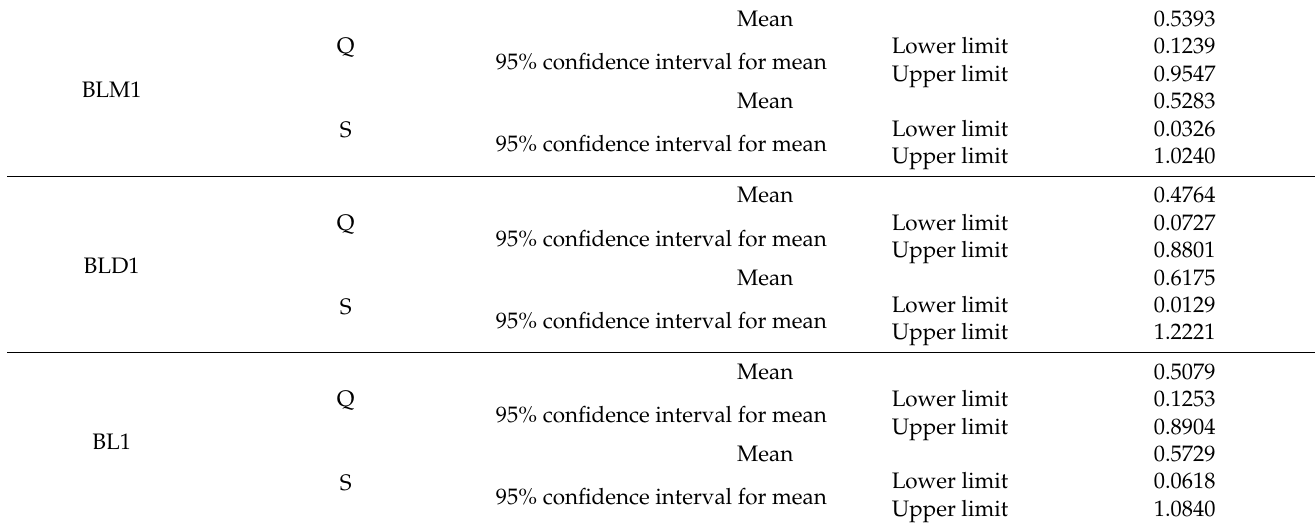
Table 1. Bone level values for the two implants at the time of loading (3 months after insertion and 5 years after insertion). BLM1, mesial bone level at 3 months; BLD1, distal bone level at 3